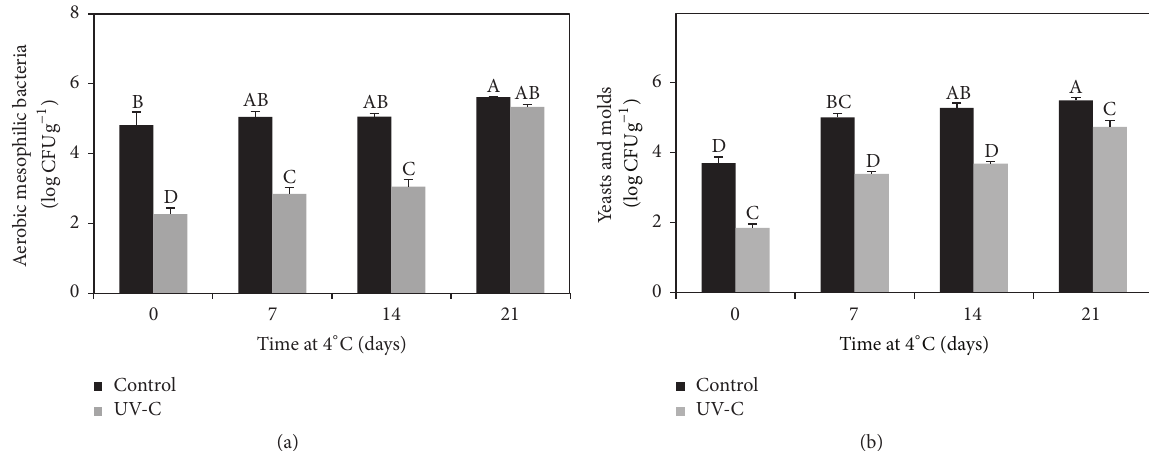
Figure 4: (a) Aerobic mesophilic bacteria and (b) yeasts and molds in control and UV-C treated (12.5kJm −2 ) carambola slices stored for 0, 7, 14, and 21d at 4 ∘ C. Bars represent the standard error ( 𝑛 = 3 ). Different letters indicate significant differences on Fisher’s test ( 𝑃 < 0.05 ).